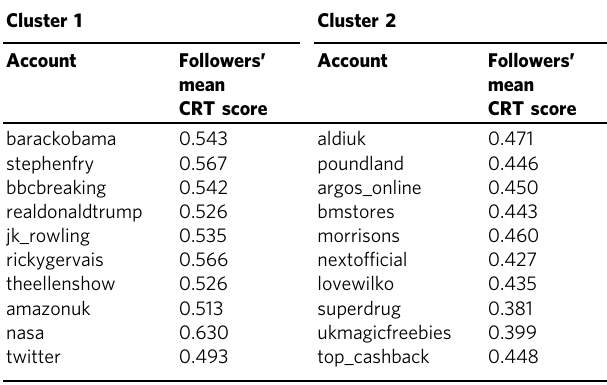
Table 2 Top accounts in each cluster within the co-follower